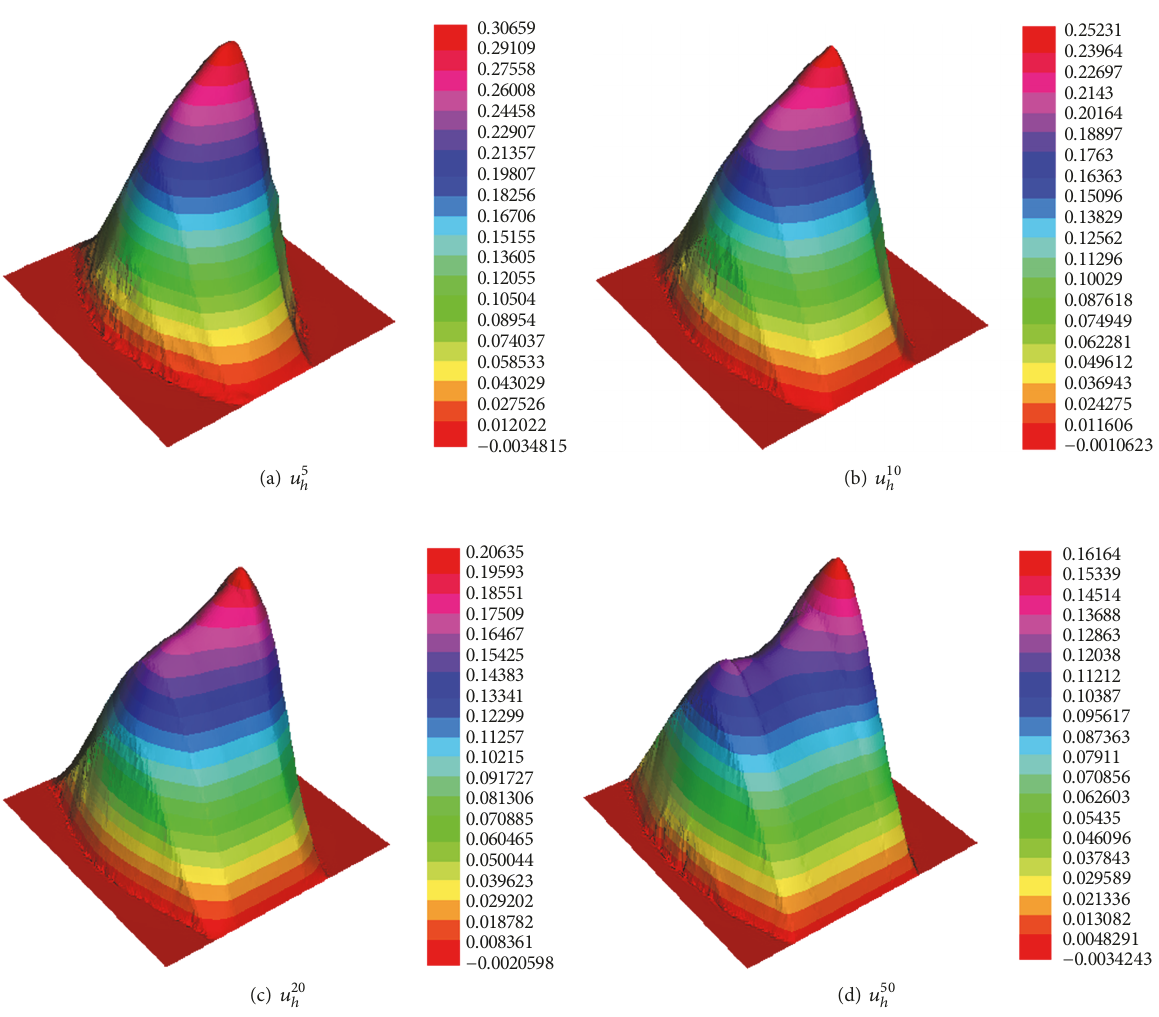
Figure 6: Numerical solutions for Application 2.